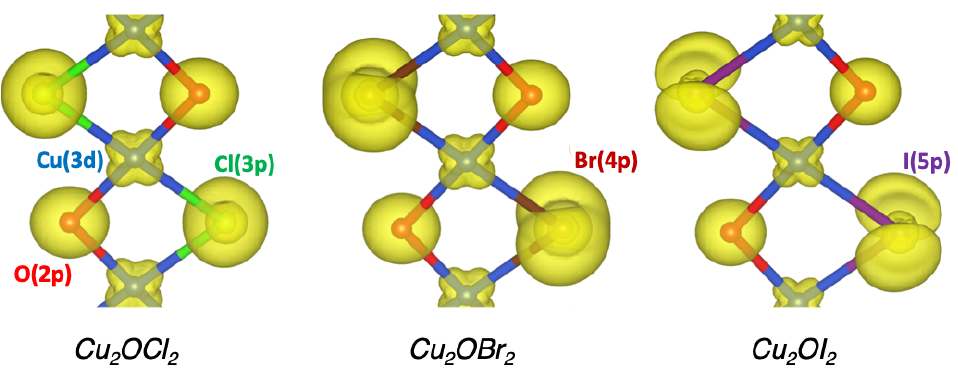
Figure 3. Electronic density corresponding to the top of the valence band (from − 0.5 to 0 eV with respect to E F ) for the Cu 2 OX 2 compounds (X = Cl, Br, I) deduced from PBE0 on-site calculations on the ground state AFM collinear order. Isovalue is set to 0.1 electron/Å 3 . Blue, red, green, brown and violet spheres indicate Cu, O, Cl, Br and I atoms,